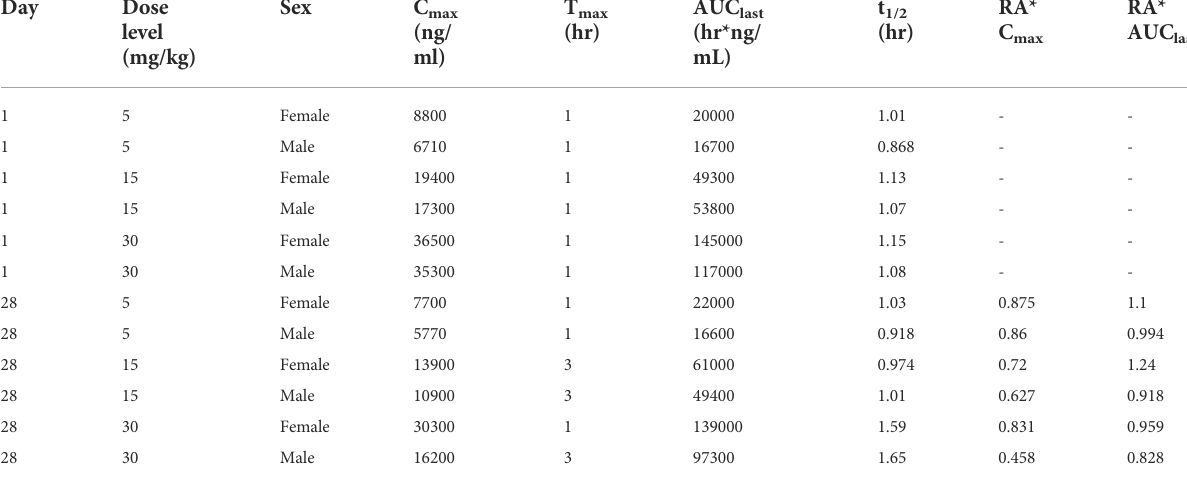
*RA, Ratio of accumulation as measured by AUC last and C max